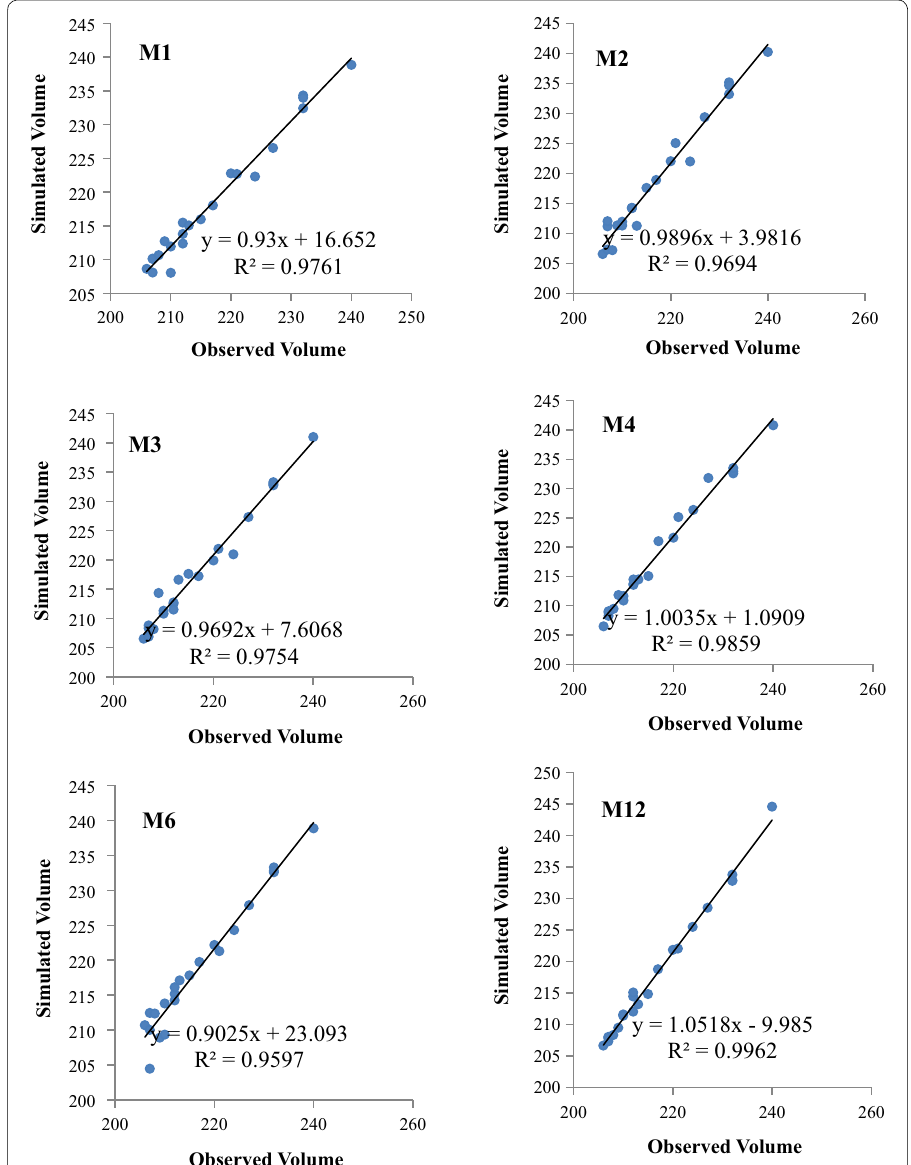
Fig. 6 Simulated (predicted vehicle frequency) vs observed traffic volume for best 6